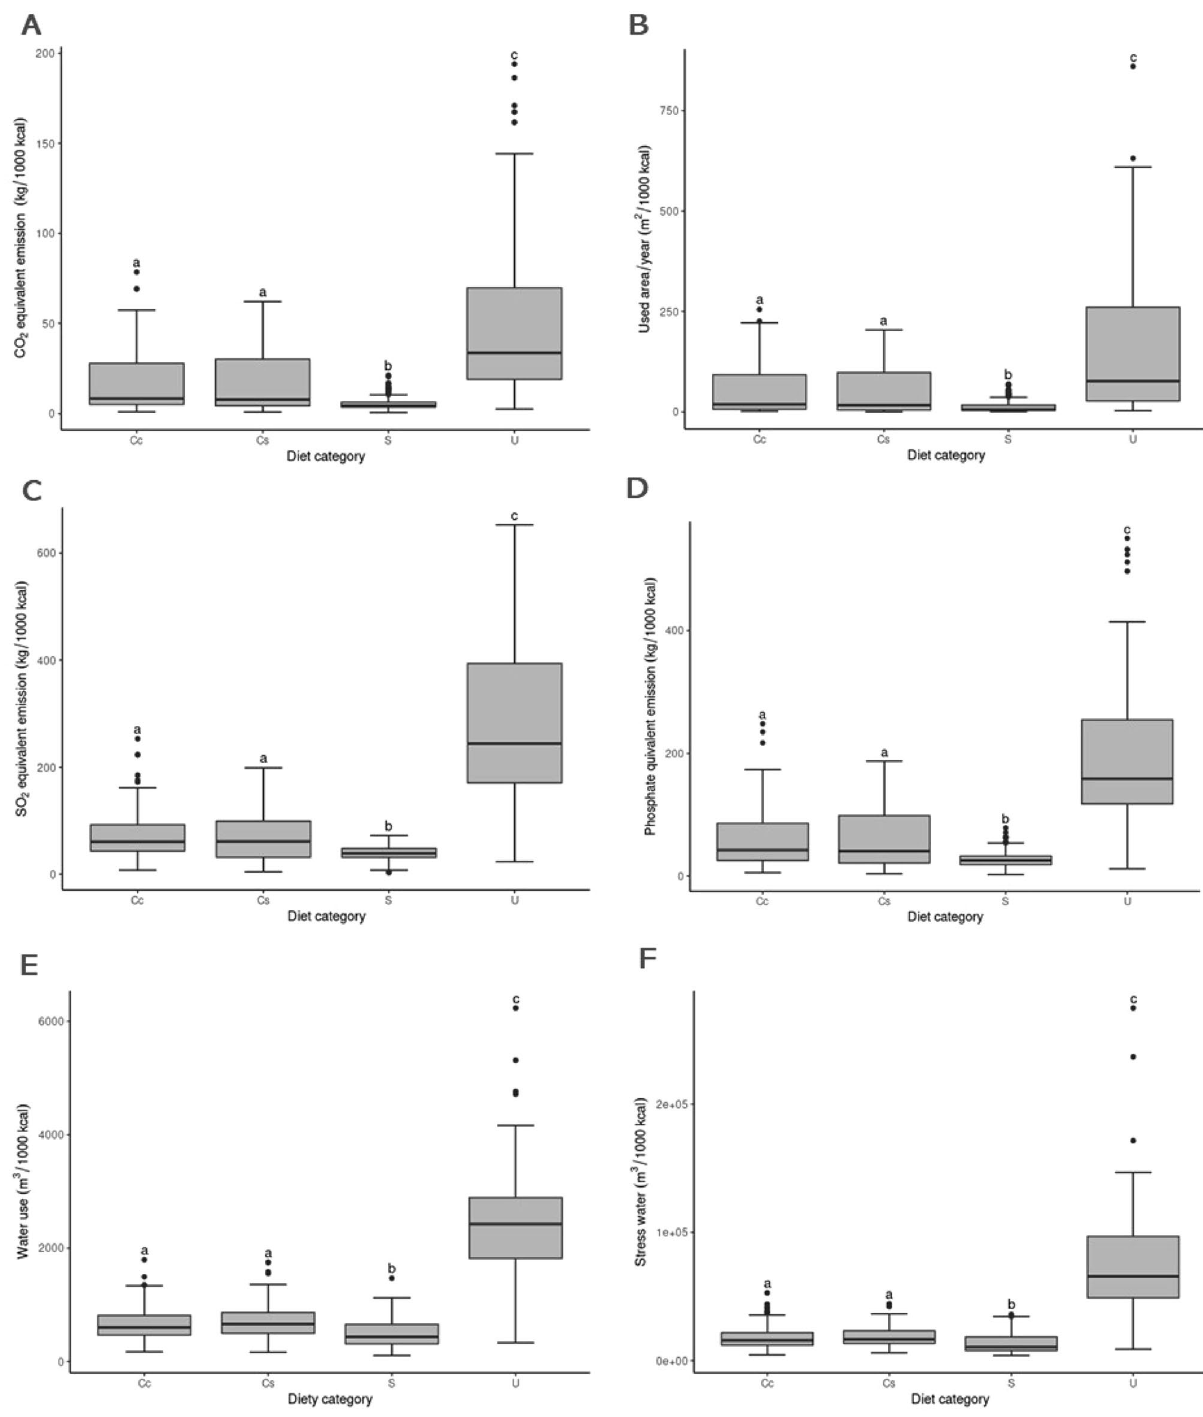
Figure 2. Boxplots of the estimated environmental impact per 1000 kcal of diets for dogs according to the type of diet for the variables carbon dioxide equivalent emission, land use, acidifying emission, eutrophying emission, freshwater withdrawal, and stress-weighted water use. Plots of the same variable that have different letters differed (p < 0.05) according to the multiple comparison test between groups. Diet category: Cc homemade diets, Cs website homemade diets, S dry diets, and U wet diets.